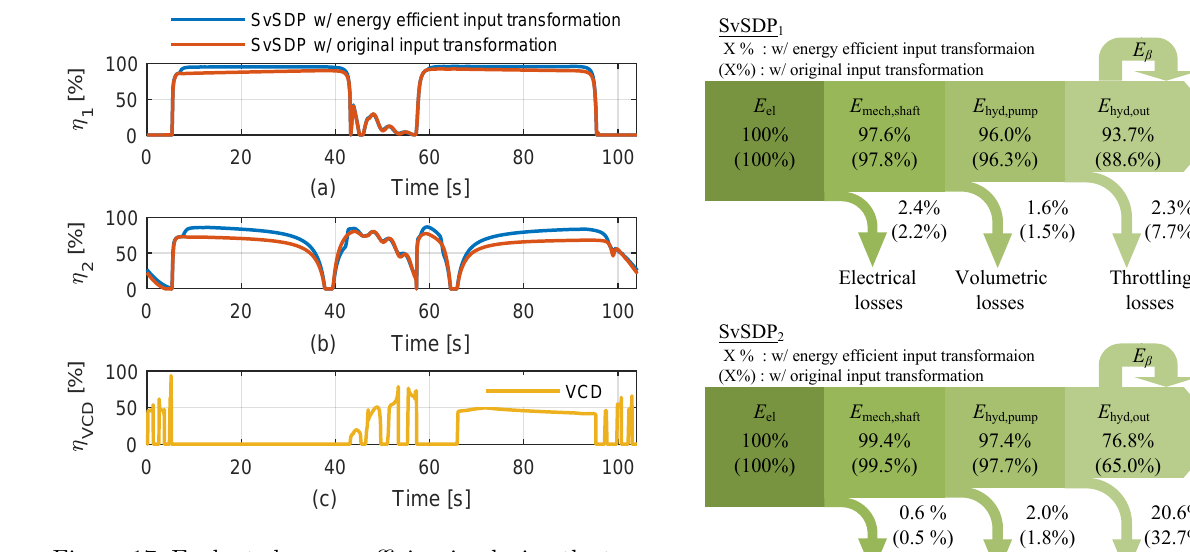
Figure 17: Evaluated energy efficiencies during the tra- jectory evaluated using Eq. (62) and Eq. (63).